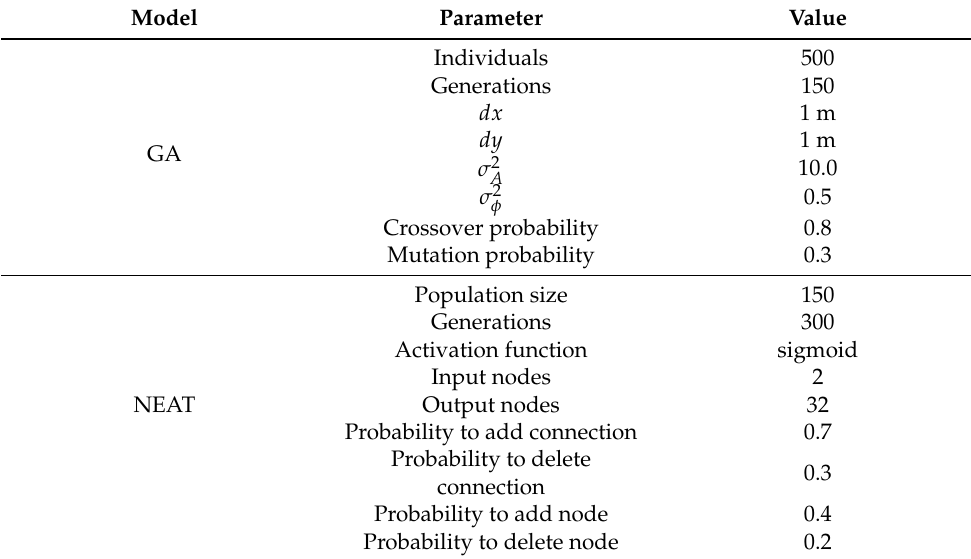
Table 3. Parameters used for the evaluated algorithms.